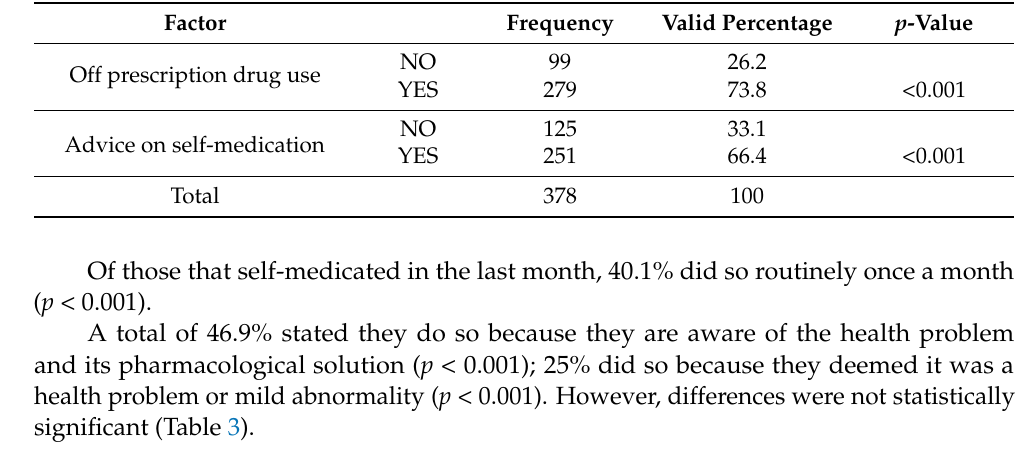
Table 3. Factors linked to